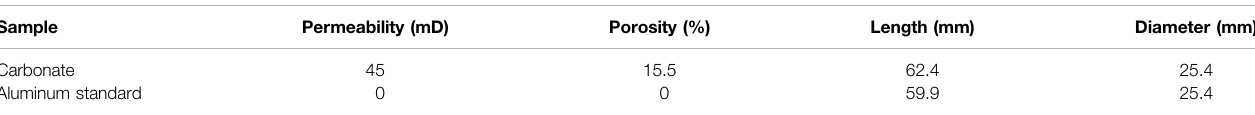
TABLE 2 | Properties of the carbonate sample and aluminum standard.